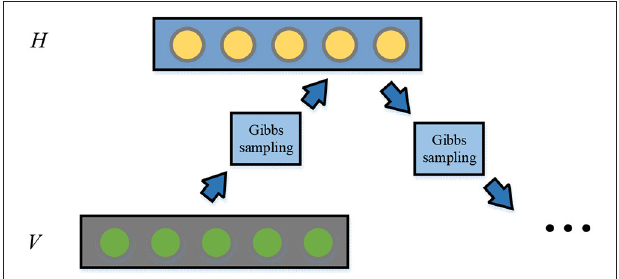
FIGURE 4 | Flowchart of CD algorithm.